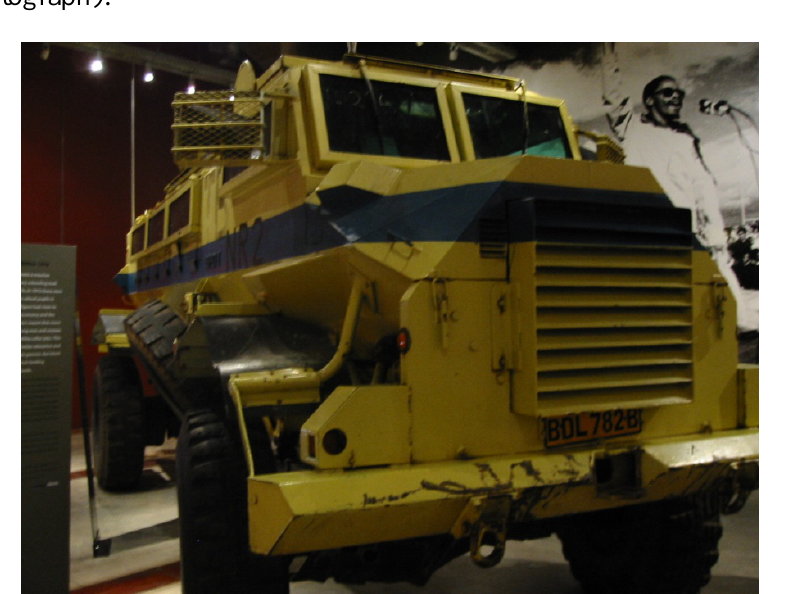
Figure 15. Casspir armored vehicle on display in the Apartheid Museum, Johannesburg (author’s